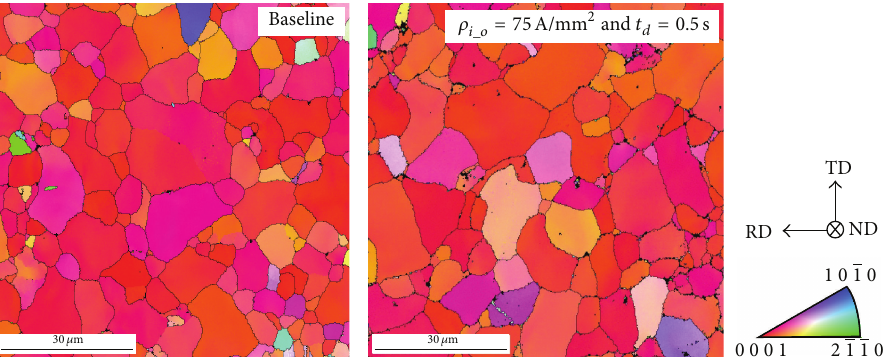
Figure 11: EBSD orientation (normal direction, ND) map with the electric pulse parameter set resulting in the highest electric energy in comparison with that without electric current